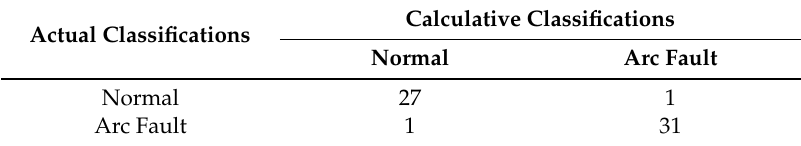
Table 3. Confusion matrix for arc fault detection